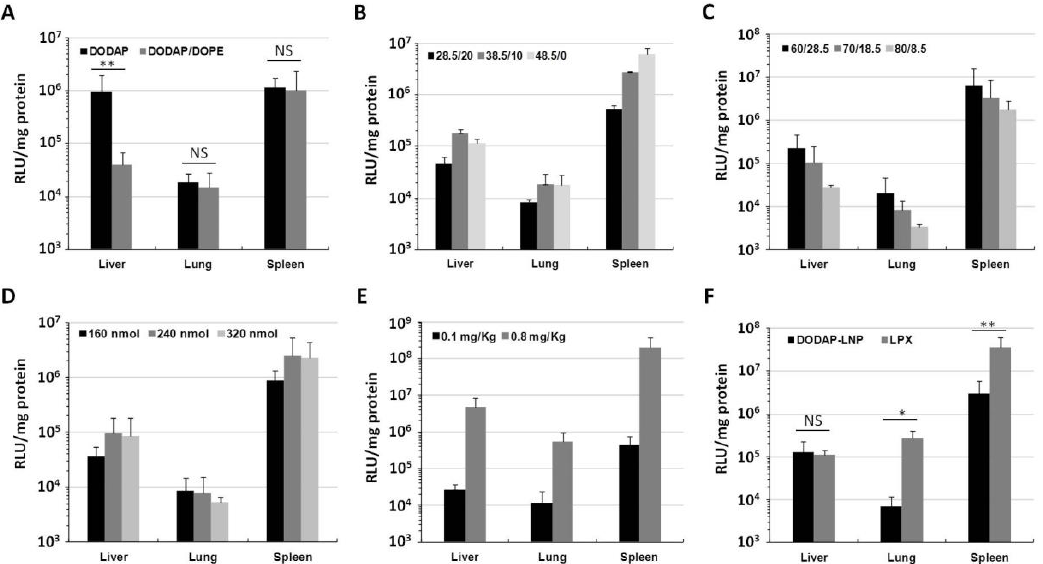
Figure 1. Luciferase activity in vivo. ( A ) Luciferase activity of DODAP-LNP prepared with or without DOPE. The LNP that was injected contained 0.1 mRNA mg/kg and luciferase activity was measured 24 h after injection. Luciferase activity is expressed as relative light unit (RLU) per mg of total protein (** p < 0.01, NS: not significant, two-tailed unpaired t test). ( B – D ) Optimization of the lipid composition in vivo. ( B ) The ratio of DODAP and cholesterol (DOPE and DMG-PEG were